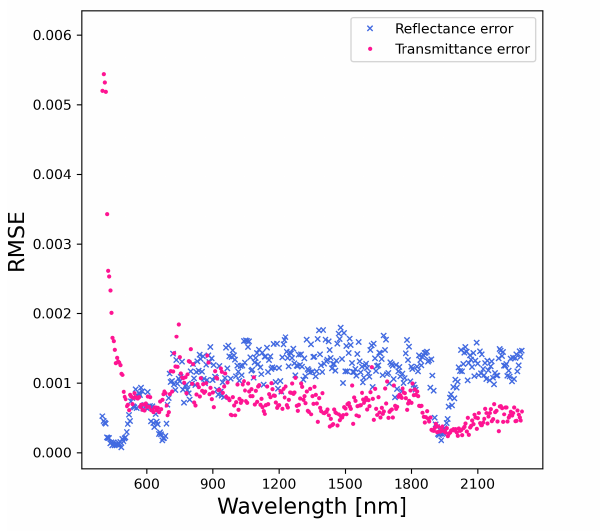
Figure 4. Mean and standard deviation of reflectance and Figure 5. Average root mean square error between measured and transmittance of 28 spectral measurements of silver birch ( B. simulated reflectance and transmittance over the 28 pendula ) leaf samples and respective simulated spectra. Mean measured reflectance and transmittance is indicated by black dotted line and respective simulated values by solid colored line. Standard deviation of modeled and measured values are indicated by colored shadows and gray dashed lines, respectively. The mean of simulation aligns almost perfectly with the measurements except where transmittance is close to zero. Variation of the measured data is also captured by the model as can be seen from the alignment of the shaded area and grey dashed line.